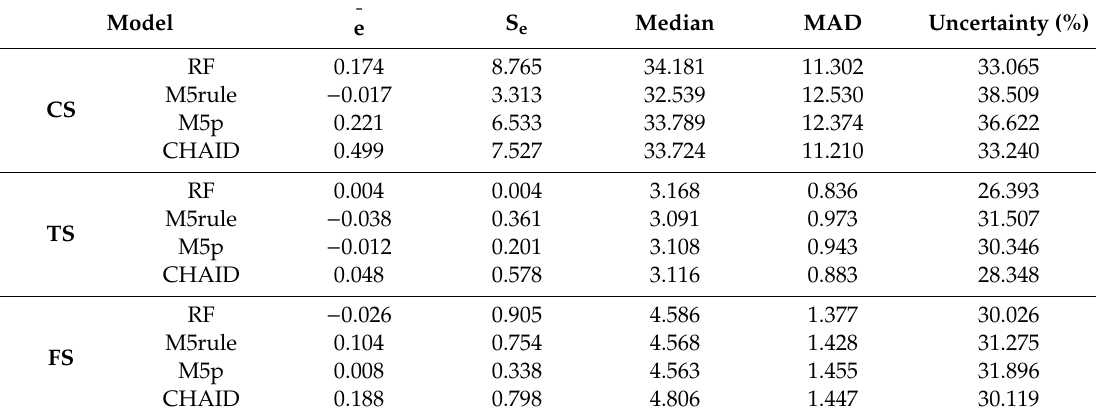
Table 7. Uncertainty quantification for all classification models.